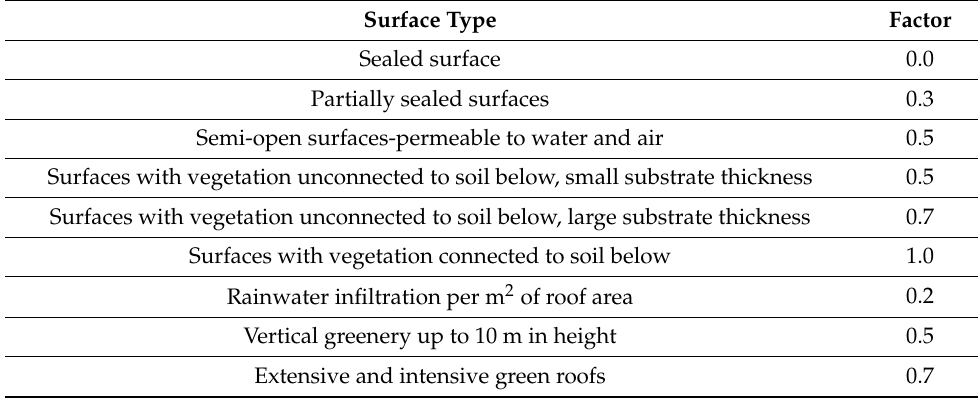
Table 2. Biotope area factor [28].